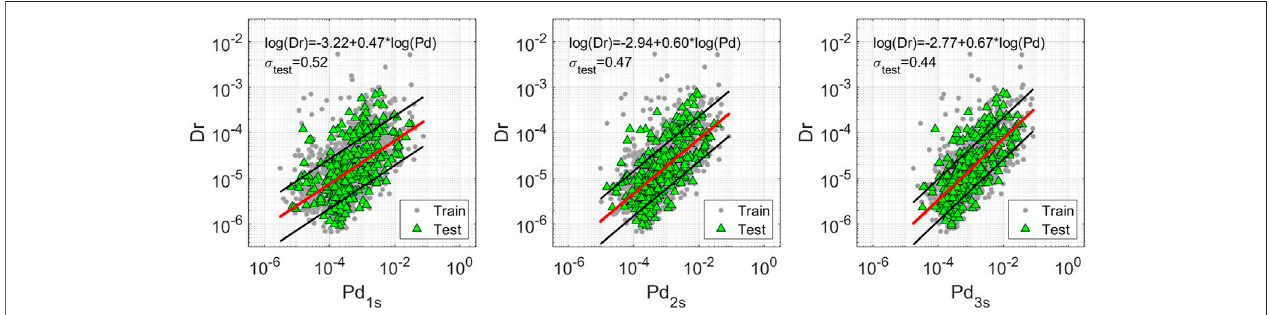
FIGURE 2 | Dr. vs. Pd (cm) of the ANX dataset for three different windows. Gray dots refer to train set data. Green dots refer to test set data. The red lines are the least square regression performed for the train set. The black lines, instead, represent the ± σ train con fi dence level. The equation of this line is written in the upper part of each fi gure with its own test residual variability, σ test .